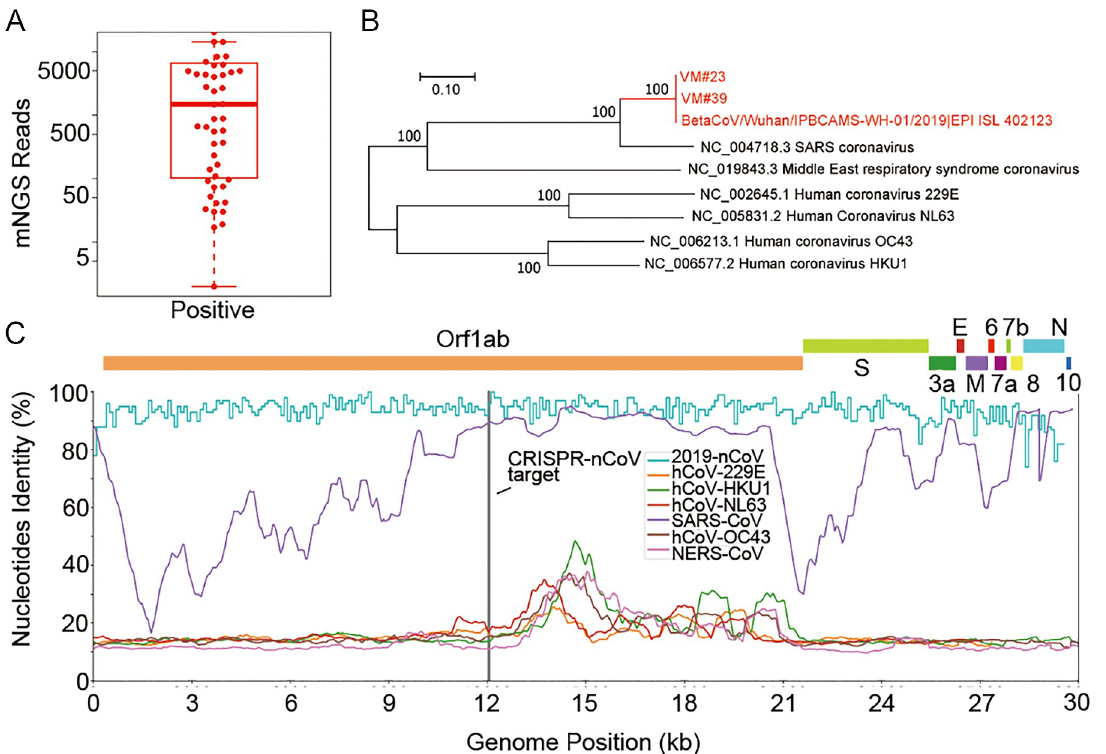
Fig 1. (A) Number of mNGS reads mapped to the genome of SARS-CoV-2 in 52 positive cases; (B) Phylogenetic tree of SARS-CoV-2s and other pathogenic CoVs; (C) SARS-CoV-2 genome and CRISPR target region. Nucleotide identity among the SARS-CoV-2 genomes, including 52 in our cohort and 2,439 from public databases (Blue), between SARS-CoV-2 (NC_045512.2) and other pathogenic CoVs (Red, SARS-CoV; others as indicated). Brief gene locations are presented above and the target region for CRISPR-COVID is indicated in